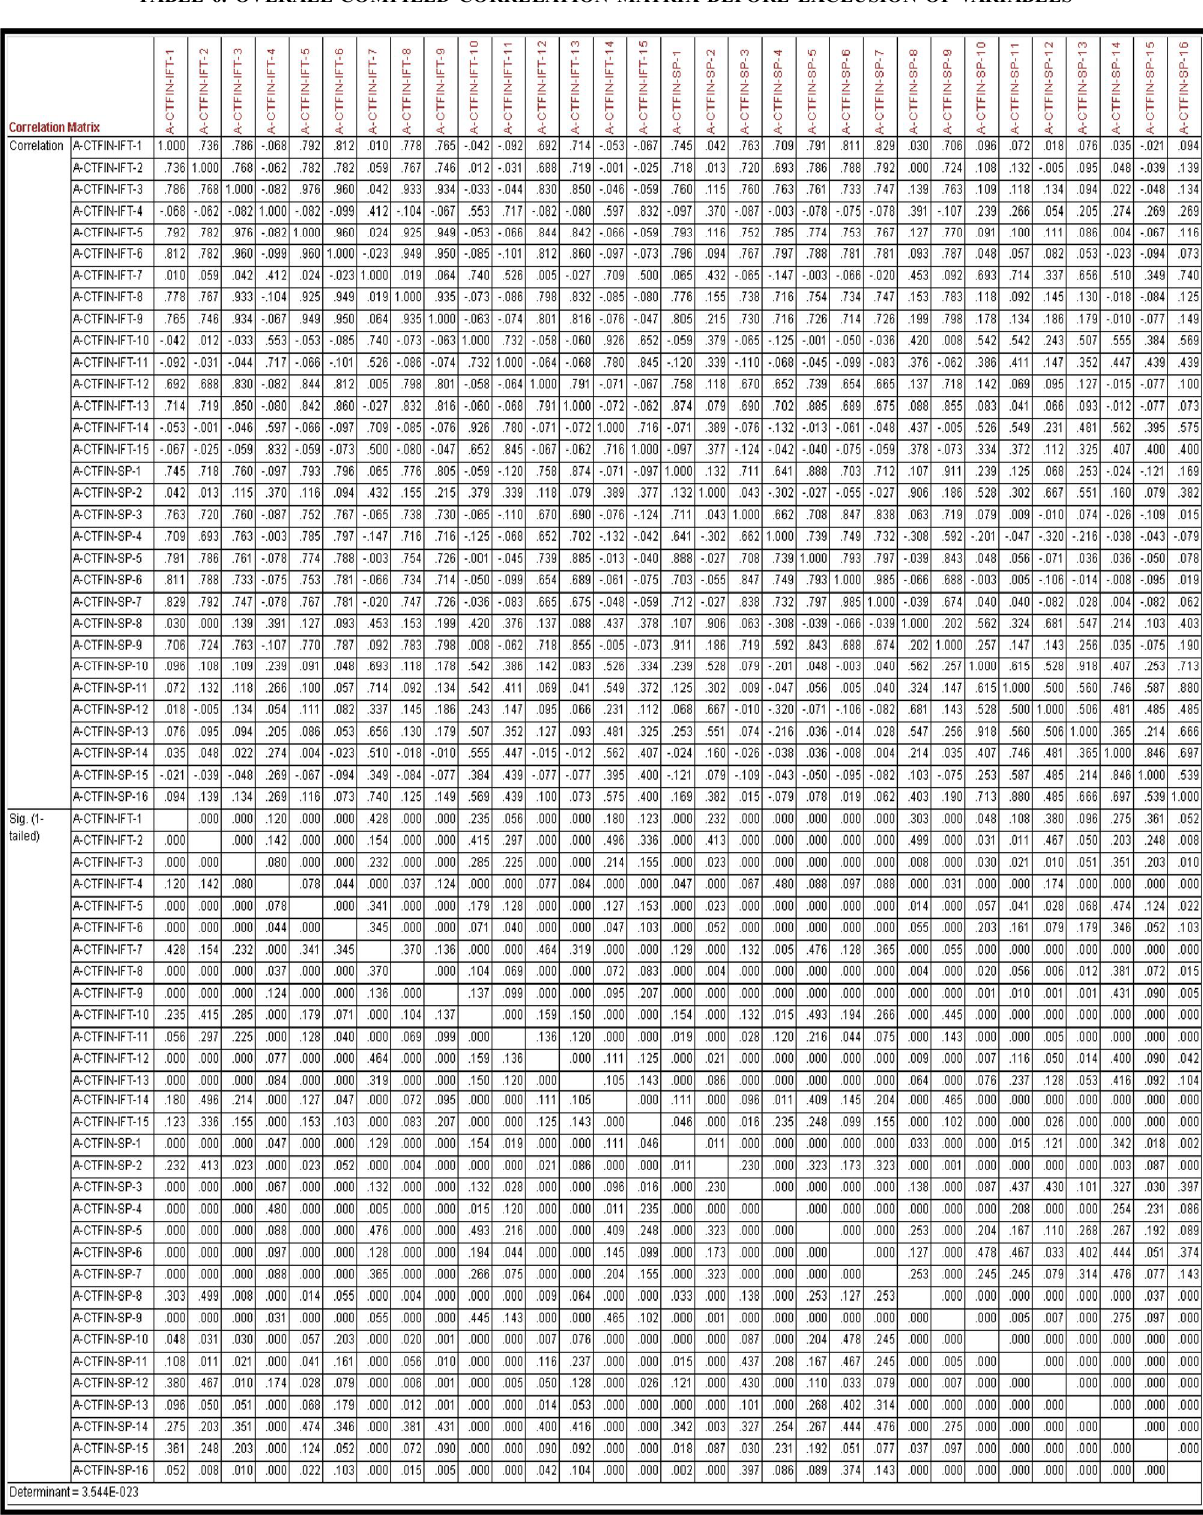
TABLE 6. OVERALL COMPILED CORRELATION MATRIX BEFORE EXCLUSION OF